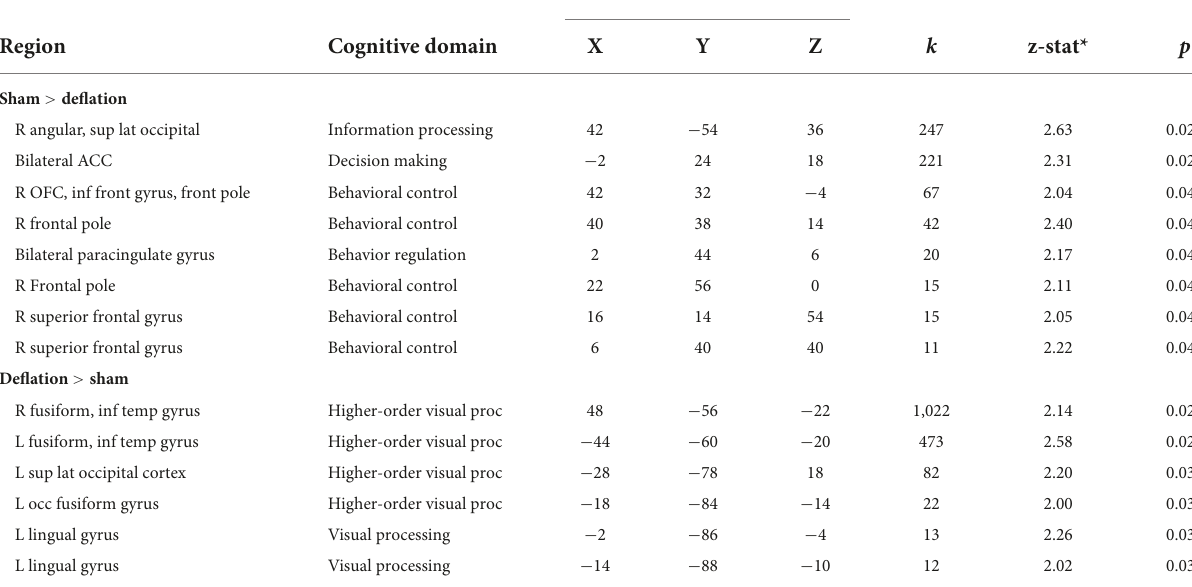
TABLE 2 Regions where activation in response to food images (compared to degraded images) differs between the sham (i.e., restricted) compared to deflated condition.